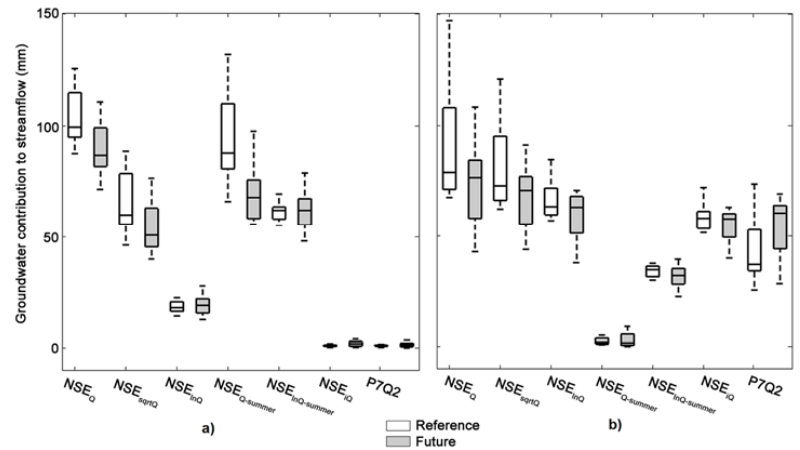
Figure 13. Sum of groundwater contribution to streamflow during the summer simulated with the SWAT model for the ( a ) Cowansville sub-watershed; and ( b ) Noire River sub-watershed.